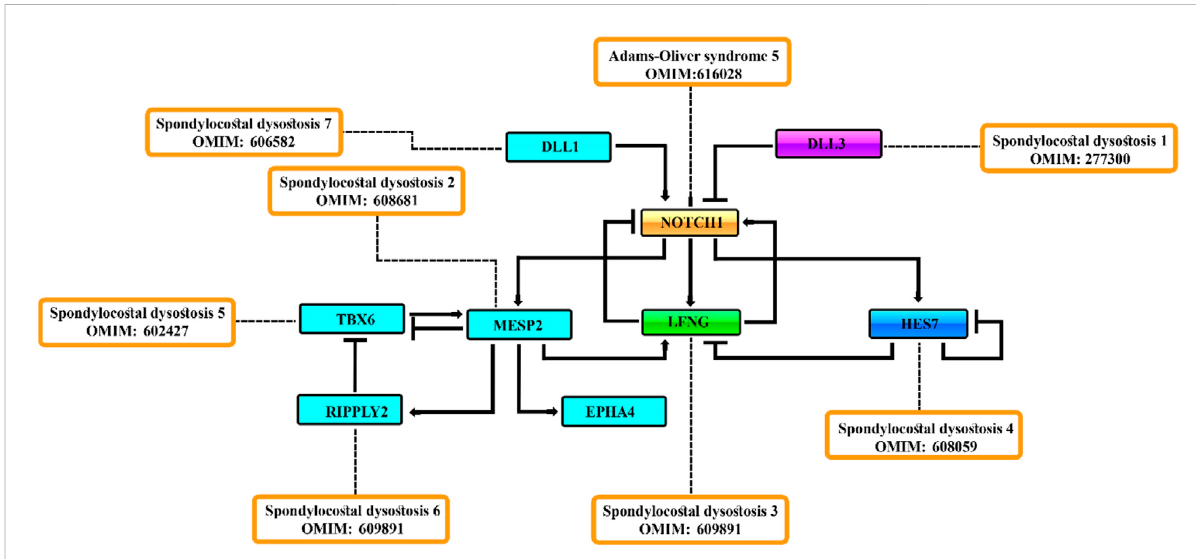
FIGURE 4 Negative feedback [act as repressors] loop consisting of the MESP2 , LFNG , HES7 , and DLL3 genes regulate the Notch-signaling activity during